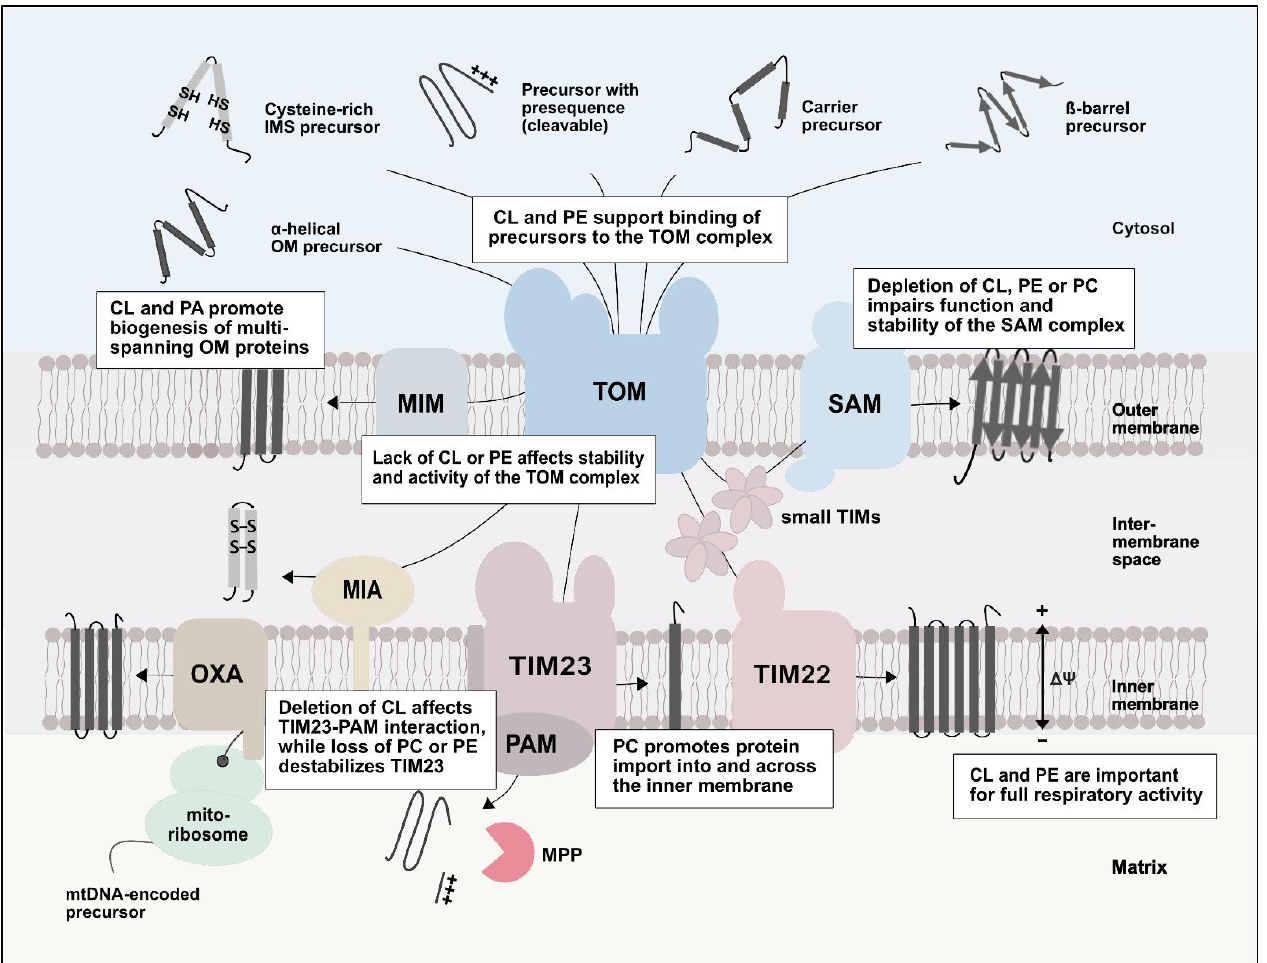
Figure 3. Role of phospholipids in mitochondrial protein import. Alterations in the composition of phospholipids of the mitochondrial membranes affect protein import pathways and protein translocases at different levels. The phospholipids CL, PE and PC are important for the stability and function of outer and inner membrane protein translocases. The depletion of CL or PE affects the respiratory chain, which causes a reduction of the membrane potential and impaired protein translocation across and into the inner membrane. Figure 3 is adapted from [19].